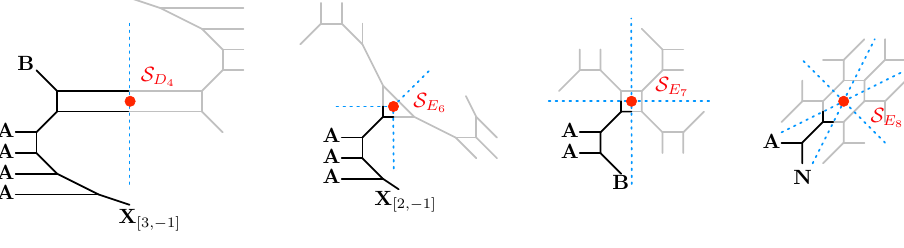
Figure 26 . The Z 2 , 3 , 4 , 6 quotients of 6d E -string on a circle (or 5d SU(2) + 8 F ).